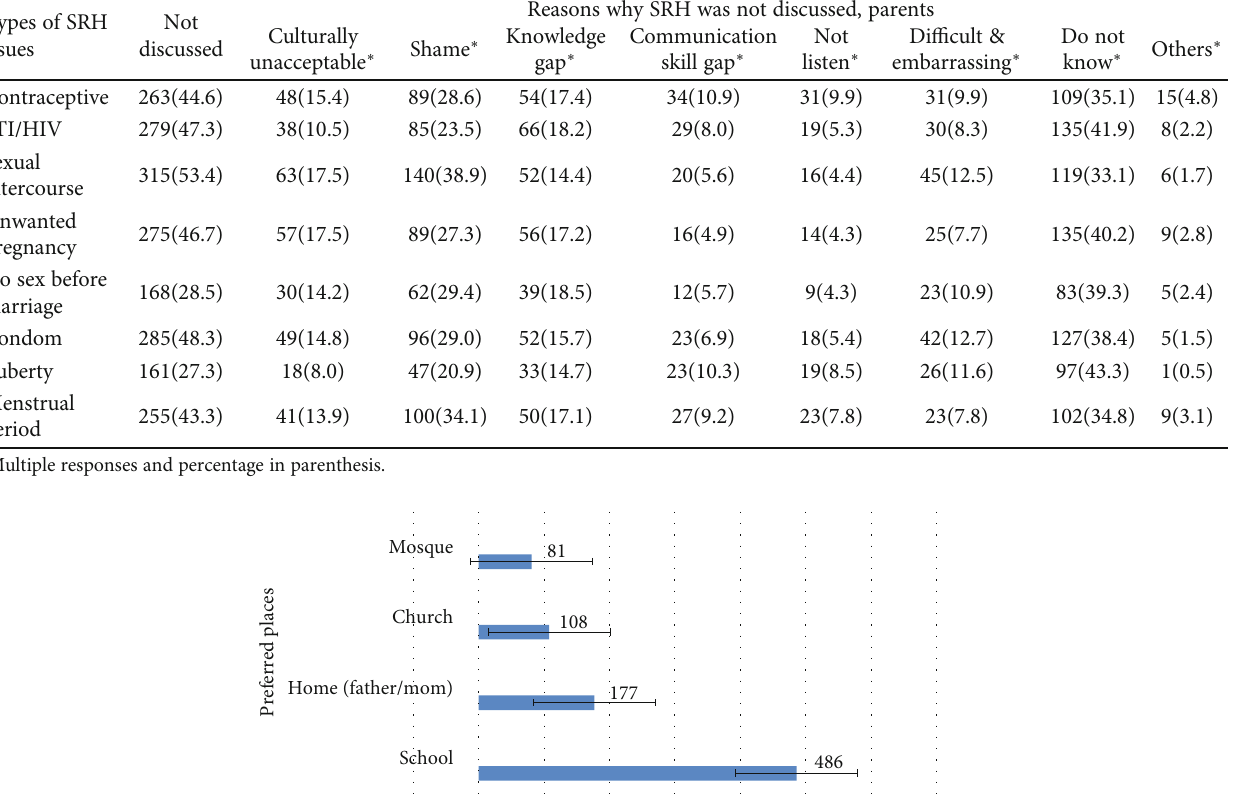
Table 3: Reasons reported by adolescents for not discussing SRH issues with their parents among secondary and preparatory school students in Ambo Town, Oromia region, Ethiopia, 2019.